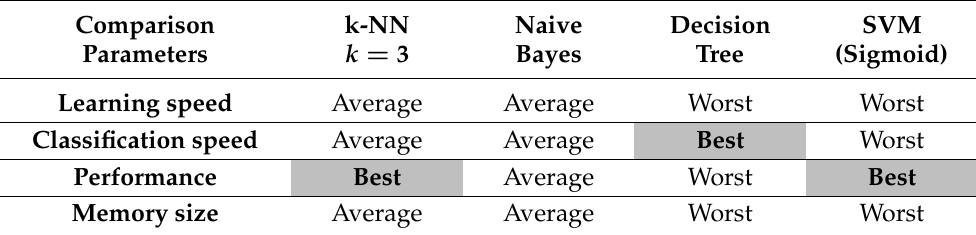
Table 5. Classification algorithms comparative parameters’ study under Stage I.